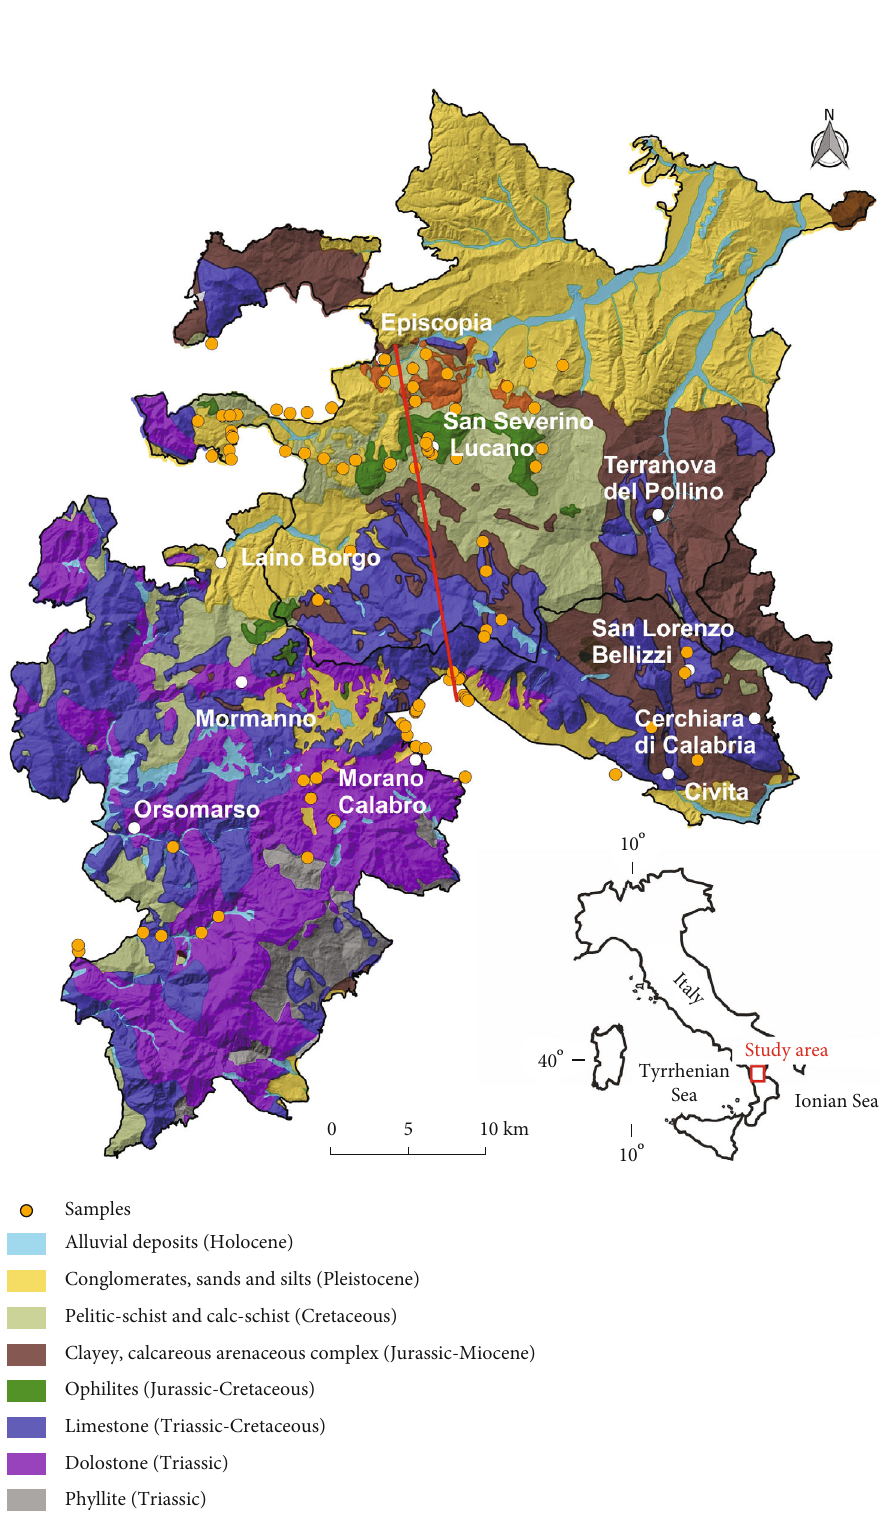
Figure 1: Lithological map of the Pollino National Park area. In the fi gure, the trace (red line) of the schematic geological section (see Figure (Figure 9) and the location of all considered samples are